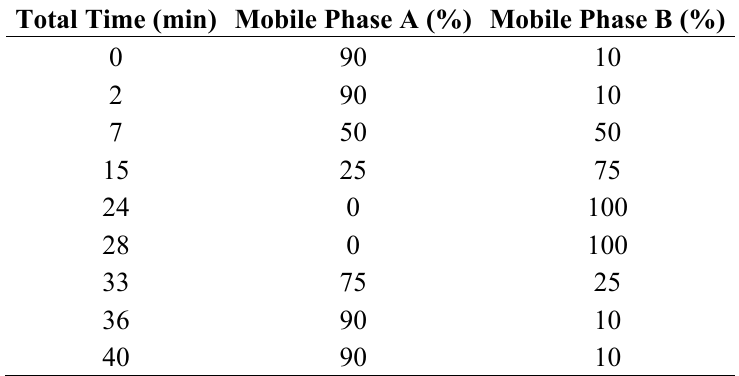
Table 2. Gradient program of the HPLC-MS/MS method